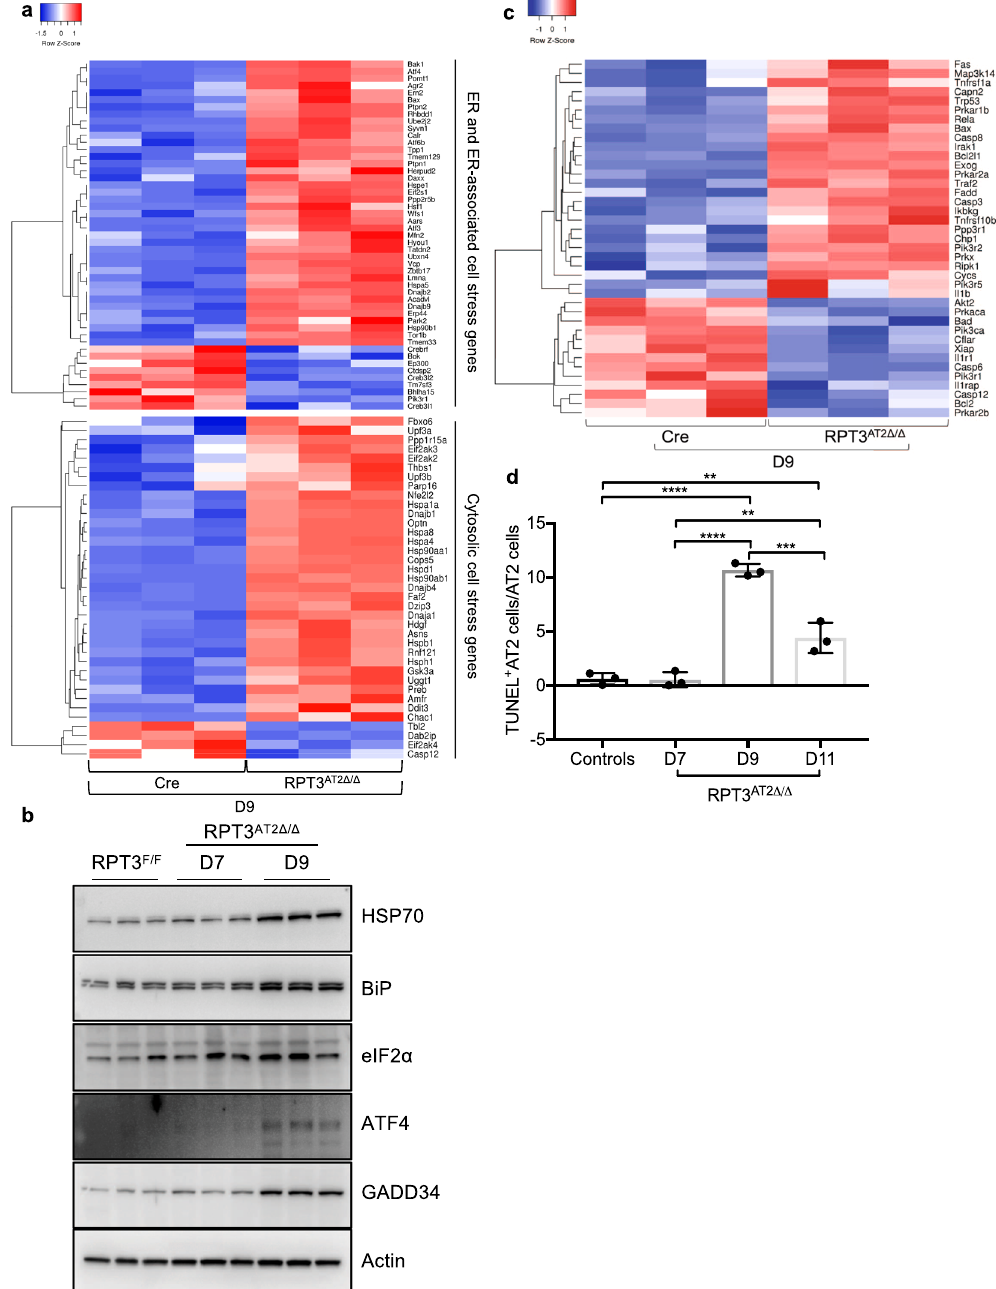
Figure 5. RPT3 deficiency results in increased cell stress and death. ( a ) Heatmap of differentially expressed cell stress response genes in AT2 cells isolated on D9. ( b ) Western blot analysis of cell stress markers in 30 μ g of AT2 cell lysates separated by SDS-PAGE. ( c ) Heatmap of differentially expressed apoptosis-associated genes in AT2 cells isolated on D9. ( d ) Percentage of TUNEL + AT2 cells assessed by morphometric analysis of Fig. S6a. Control included both RPT3 F/F mice ( Sftpc WT/CreER :RPT3 F/F mice without tamoxifen treatment) and Cre mice that were fed tamoxifen chow for 7 days. Heatmaps were z-score normalized. Adjusted p-value < 0.05. n = 3 mice/genotype. * p < 0.05, ** p < 0.01, *** p < 0.001, **** p < 0.0001 by one-way ANOVA with Tukey’s multiple comparison test. Full-length blots are presented in Supplementary Fig.